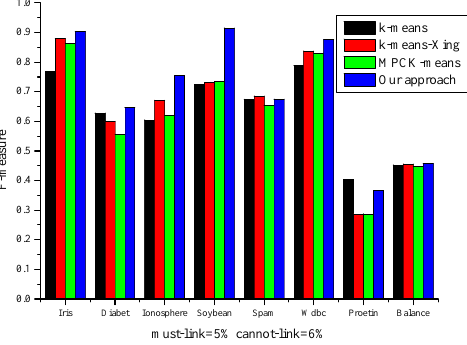
Fig. 3. The result comparison of